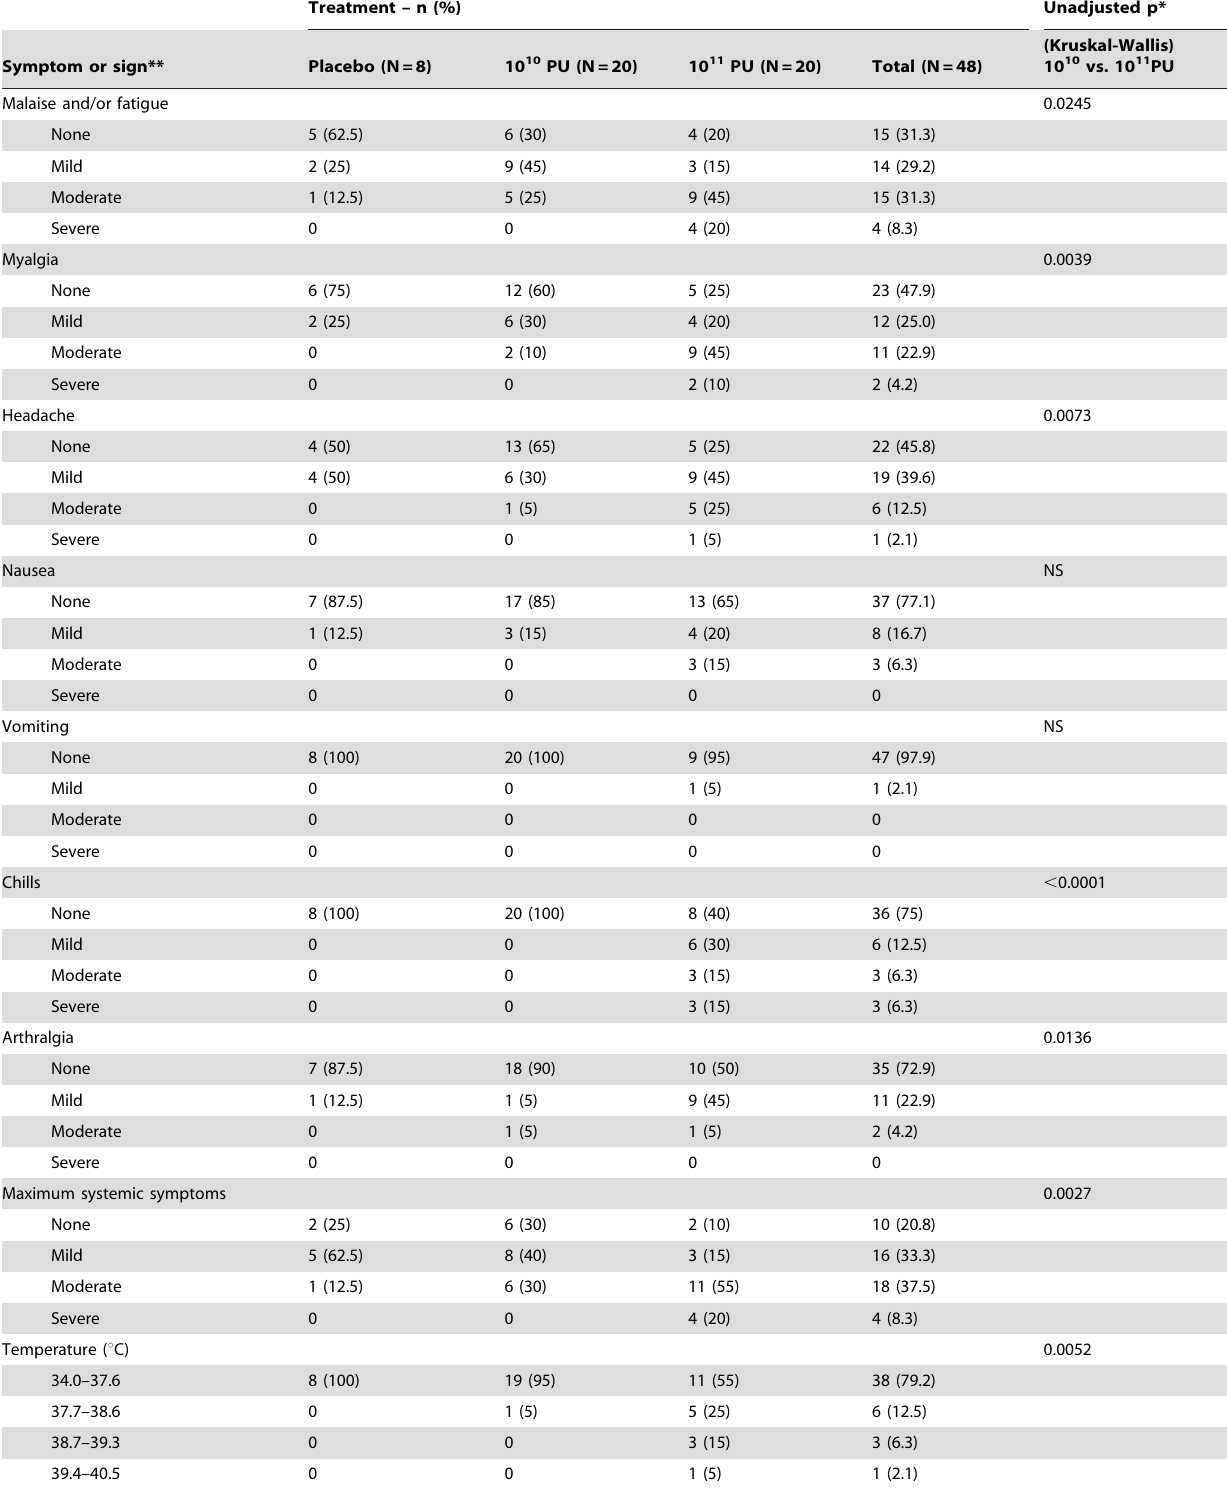
Table 3. Maximum systemic